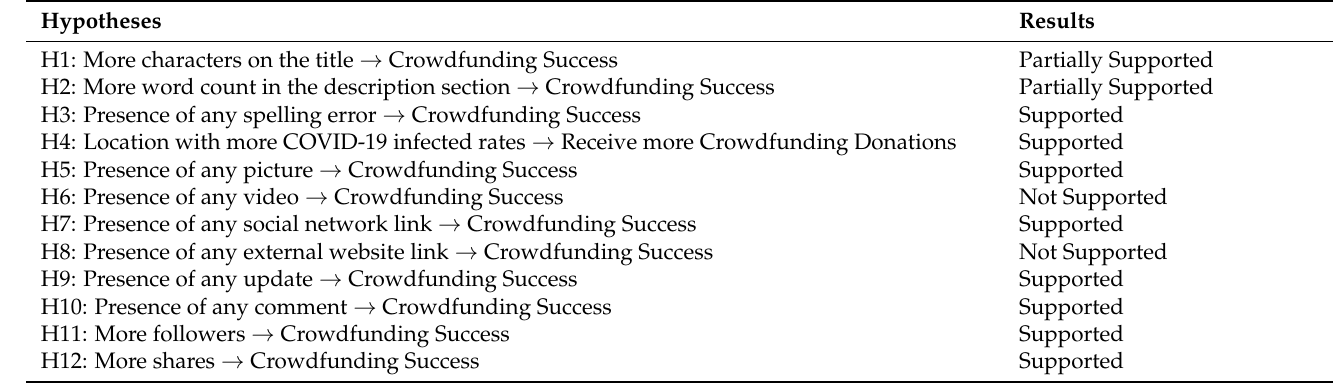
Table 6. Summary of hypothesis testing